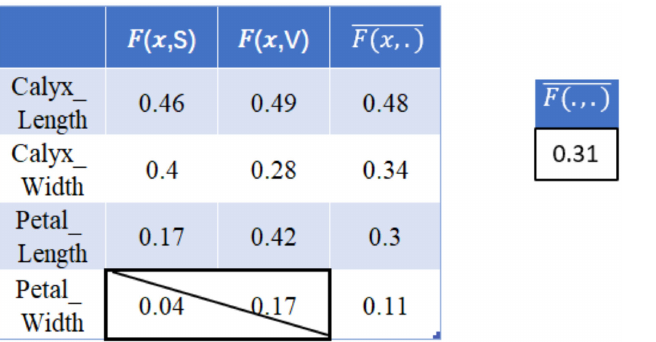
Figure 2. Principle of computation of overall feature F measure average and elimination of irrele- vant